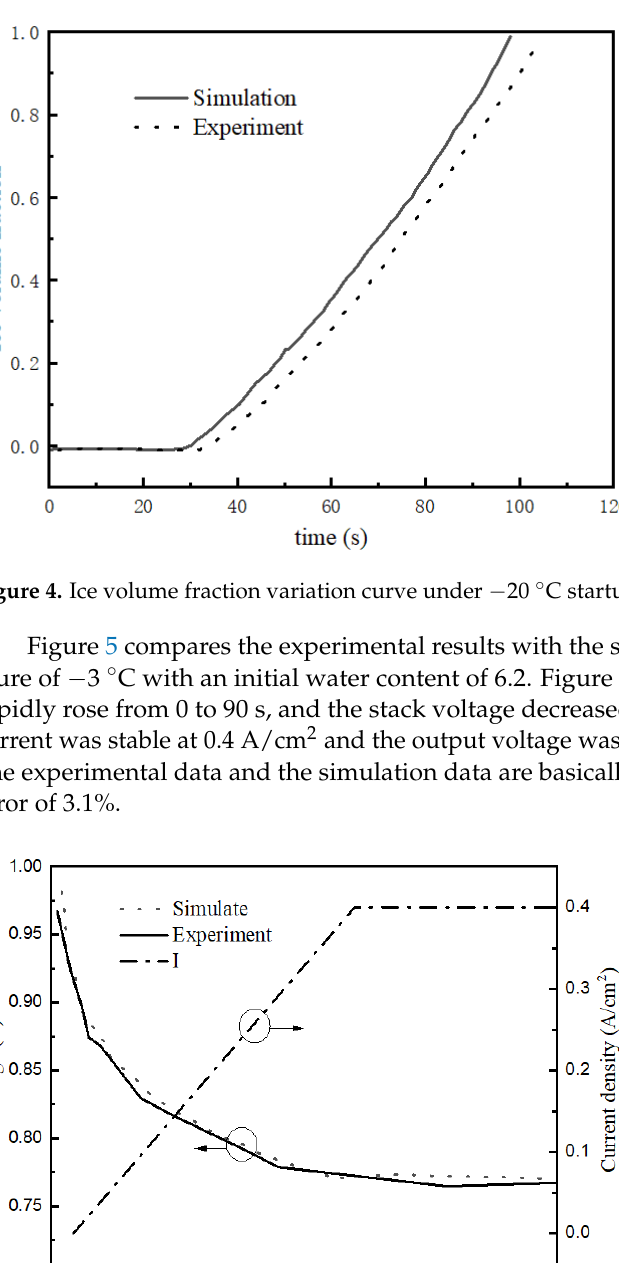
Figure 3. Temperature and voltage variation curve of stack under − 20 °C startup.